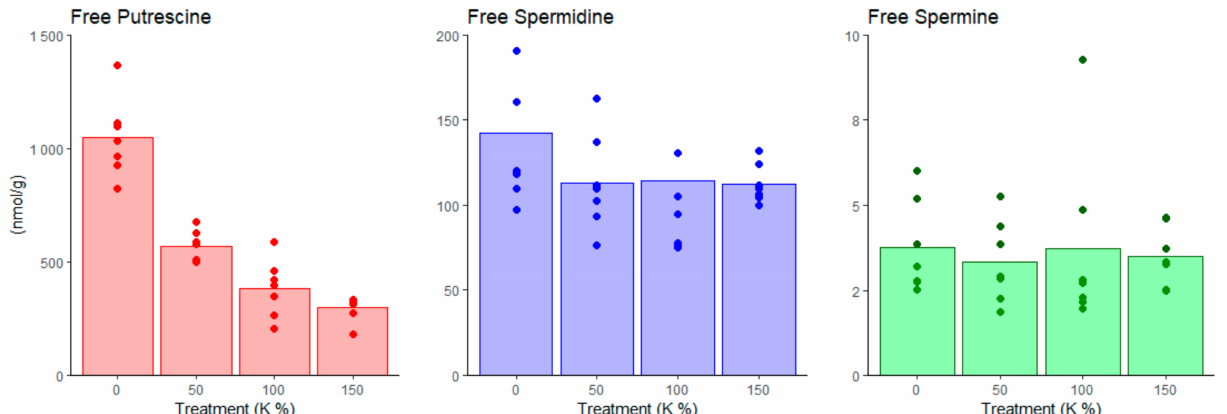
Figure 4. Free PA concentrations in Scots pine embryogenic cells under potassium treatments. PoTable 0. vs. 100%) increased the free Put concentration, whereas the concentrations of free Spd and Spm remained stable under the potassium treatments. PA contents were measured from the seven parallel samples (bottles) per